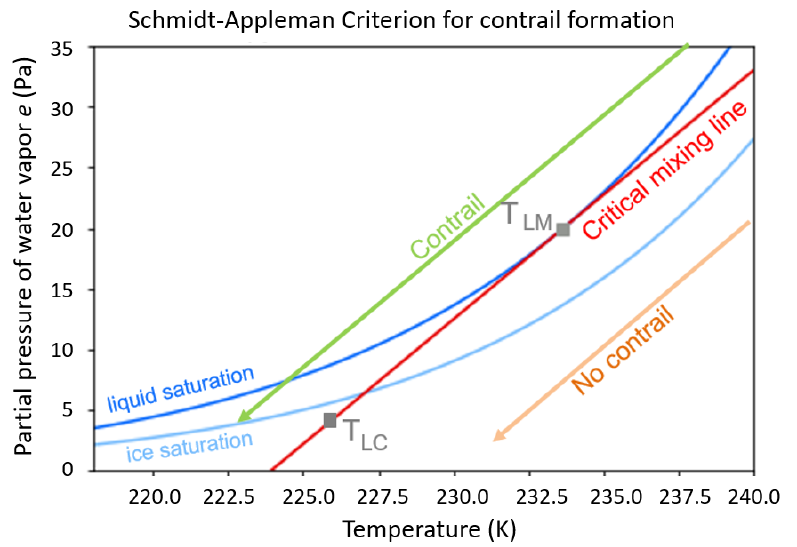
Figure 1. Partial Pressure of water vapor vs. temperature, including saturation vapor pressure of ice (light blue) and liquid saturation (blue). The mixing line at p = 300hPa is depicted in red. At point T LM , the latter is the tangent of the curve of liquid saturation. If the ambient air is colder than the threshold temperature T LC , contrails may form. This is shown exemplarily for an ambient temperature of 222.5K and relative humidity of 100%